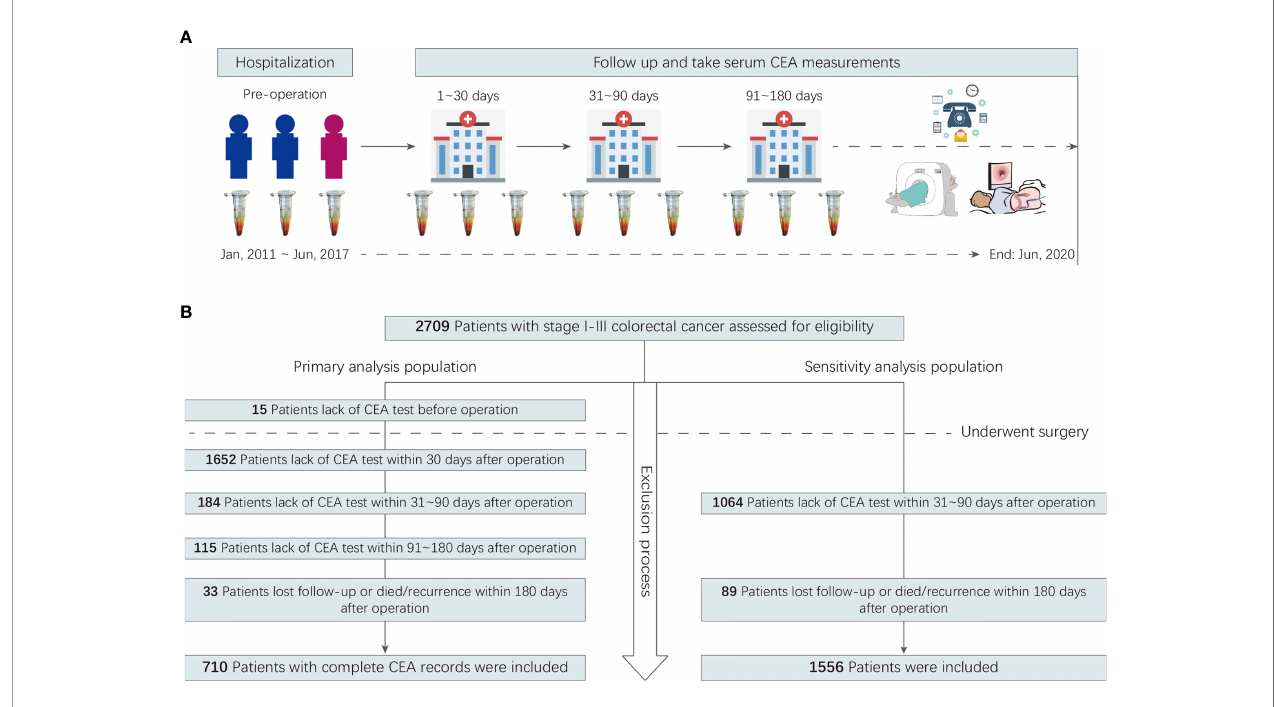
FIGURE 1 | Study fl